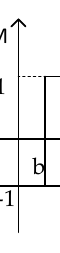
Figure 1. Preisach operator.